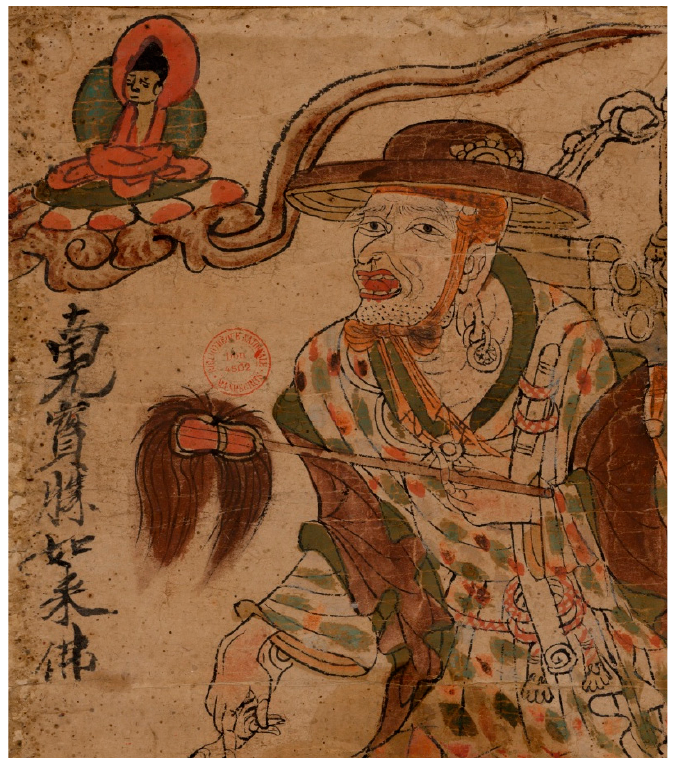
Figure 5. Itinerant Monk (detail). Dunhuang, 10th century. Ink and colors on paper, 55.0 × 32.0 cm. Bibliothèque nationale de France (Pelliot chinois 4518(39)).